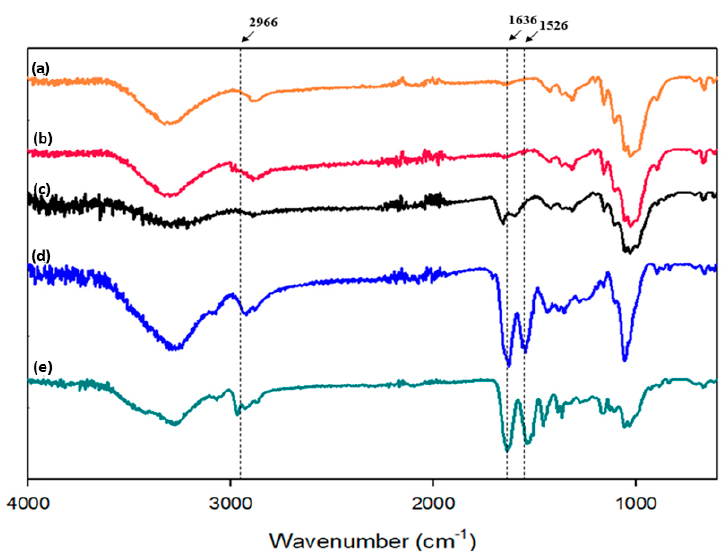
Figure 5. IR spectra of different substrates. (a) MCC; (b) cellulose(H)-BriB; (c) cellulose(H)- g -PAAm- Br; (d) cellulose(H)- g -PHEAAm-Br; and (e) cellulose(H)- g -PNIPAAm-Br.